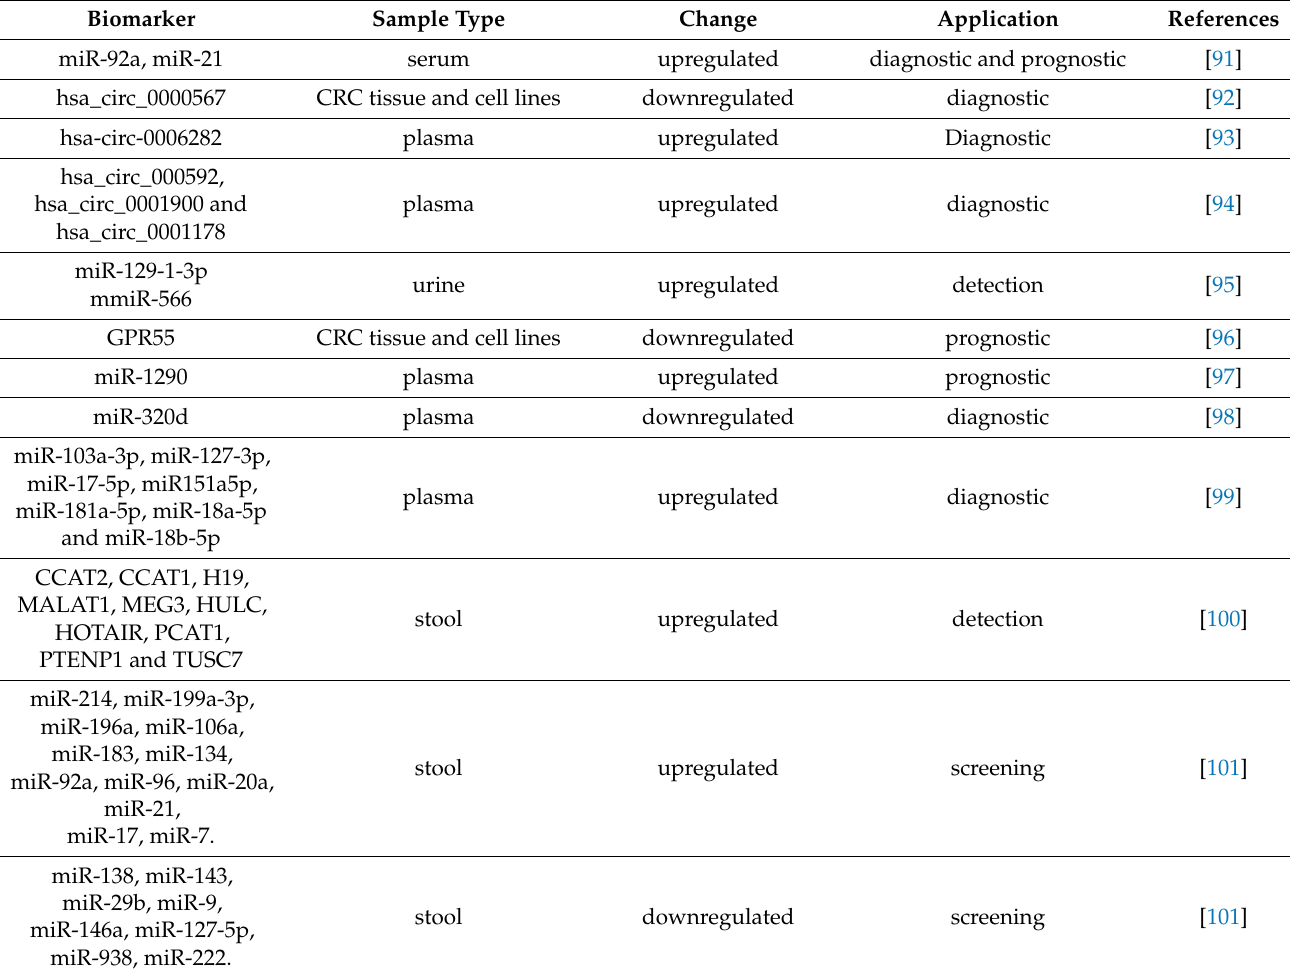
Table 2. Potential multi-omics base transcriptomics biomarkers in